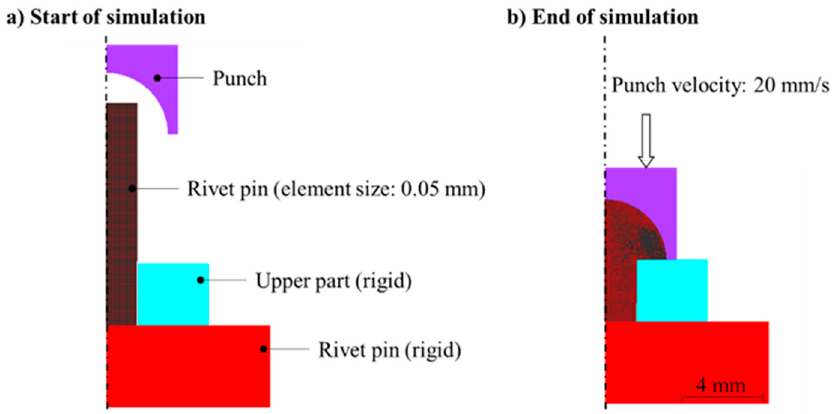
Figure 11. Basic simulation setup at the beginning ( a ) and at the end of the process ( b ).